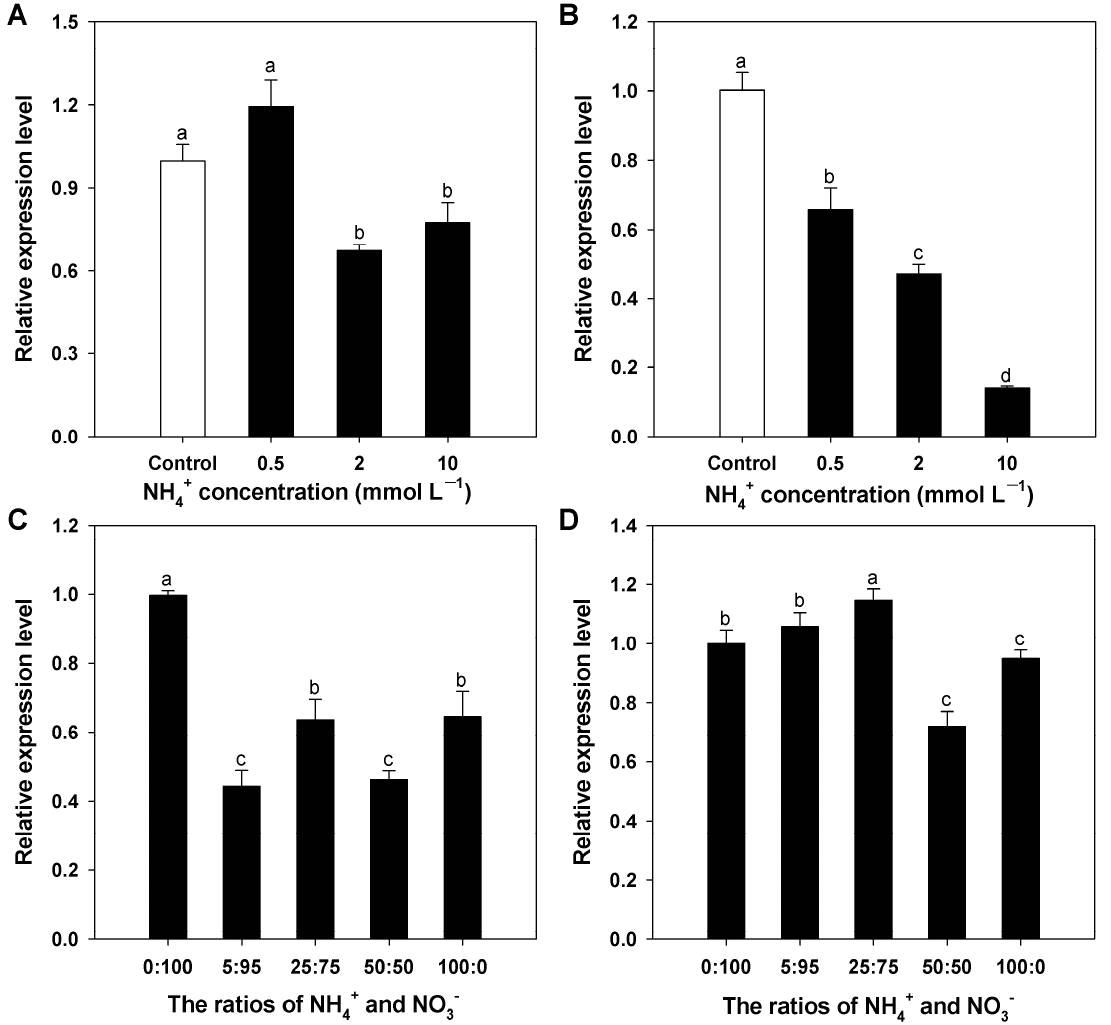
Figure 6. BcAMT1;5 expression patterns in root of flowering Chinese cabbage in response to differ- ent nitrogen (N) regimes. BcAMT1;5 expression in response to 0, 0.5, 2, and 10 mmol L − 1 NH 4+ for 2 h after N-deficiency for 48 h. ( A ) The normal N level (4 mmol L − 1 NO 3 − ) ( B ). BcAMT1;5 expression in response to different ratios of NO 3 − and NH 4+ nutrition (the total N = 4 mmol L − 1 ) for 2 h after N-starvation for 48 h ( C ) and at the normal N level ( D ). Values and error bars show the mean ± SE ( n = 3). Different lowercase letters indicate significant differences at p < 0.05.